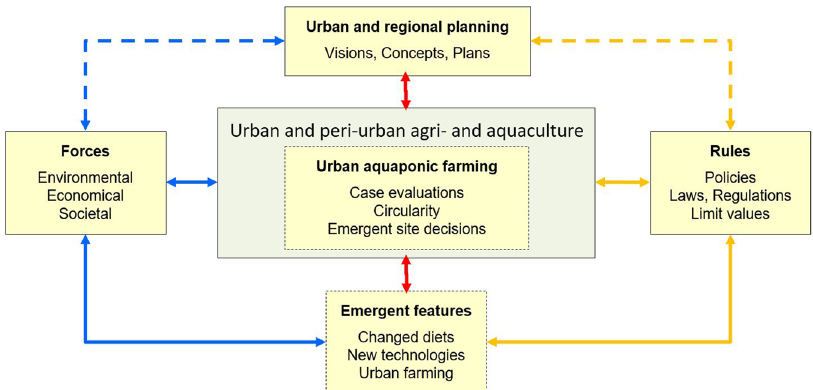
Fig. 1 Determinants of aquaponic farming in city regions. System of determinants of aquaponic farming as part of urban and peri-urban agri- and aquaculture (simpli fi ed), adopted from Baganz et al. 33 ; arrows in both directions indicate mutual causal relations, dashed lines indicate rather indirect effects, arrow colours indicate group relations; CC-BY 4.0 Gösta F.M.